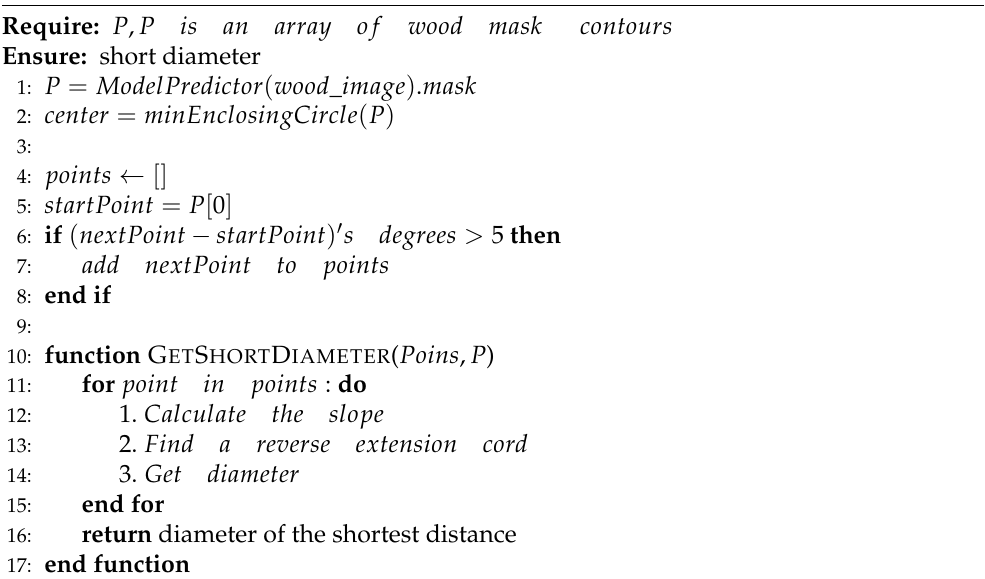
Algorithm 1 Short diameter finding.